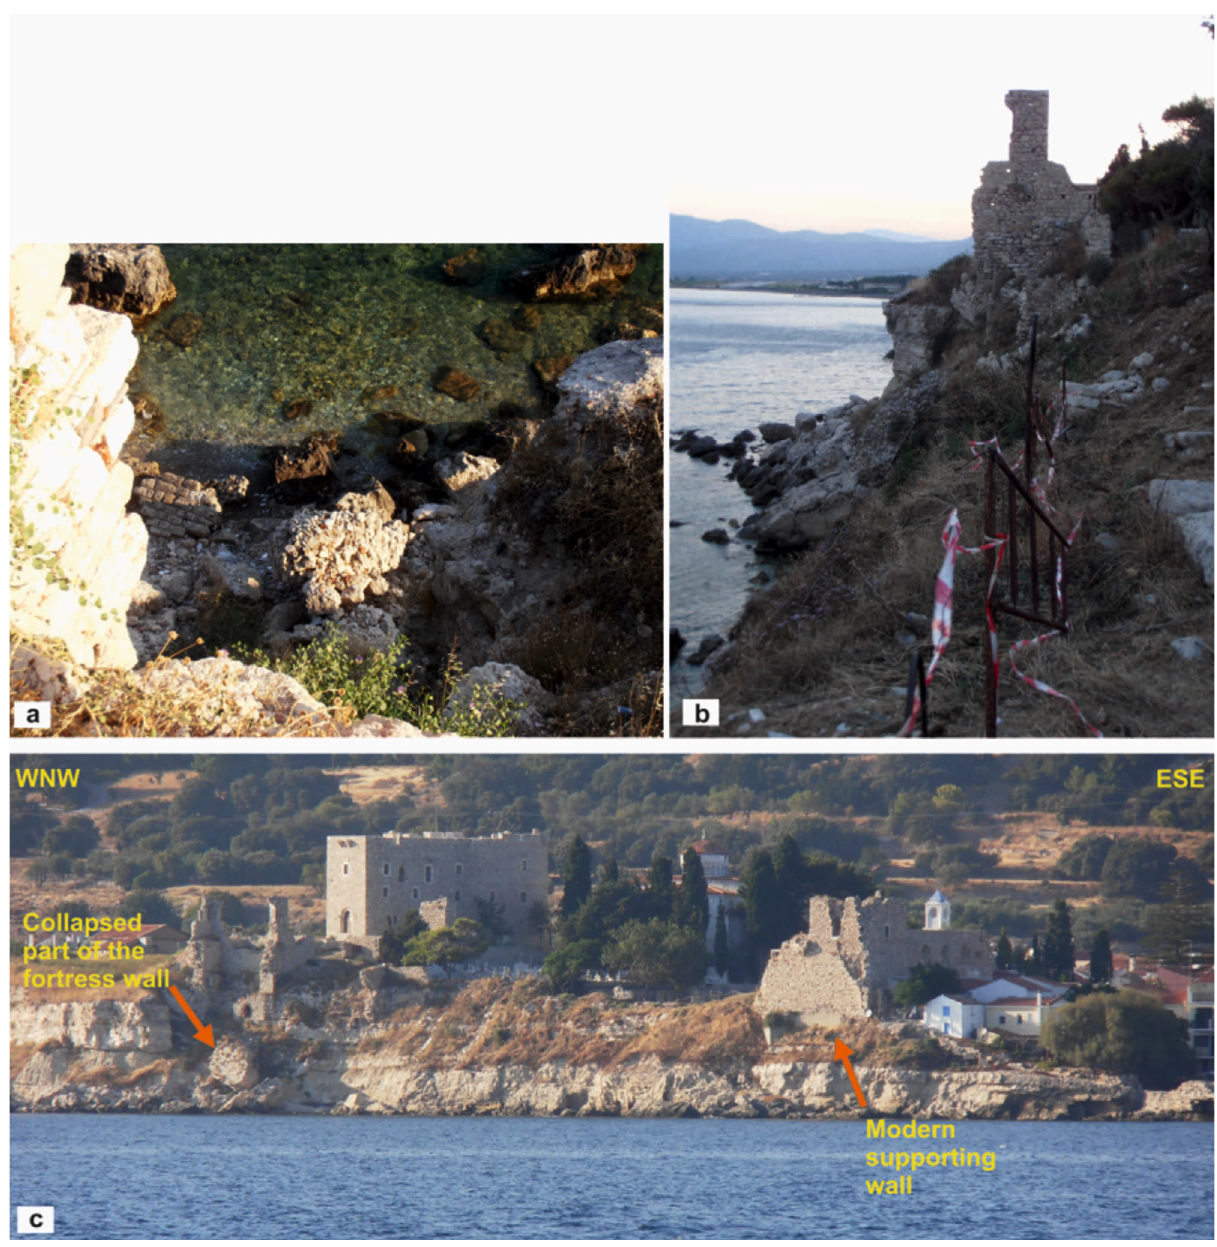
Figure 5. Slope instabilities as recorded on the southern escarpment at Logothetis Castle site (a) collapsed part of the fortress wall along with rock fall debris deposits (b) the active escarpment and the WNW fortress tower with debris deposits, (c) the preserved remains of the WNW and ESE towers of the fortification